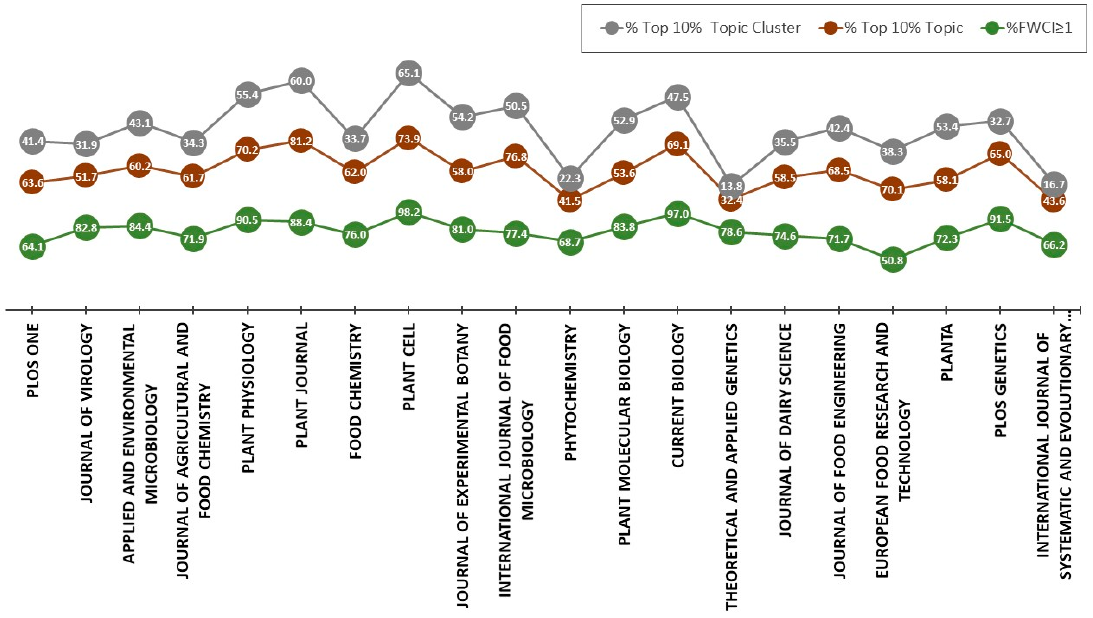
Figure 6. Percentage of articles Field-Weighted Citation Index (FWCI) ≥ 1, Top 10% Topic y Topic Cluster.